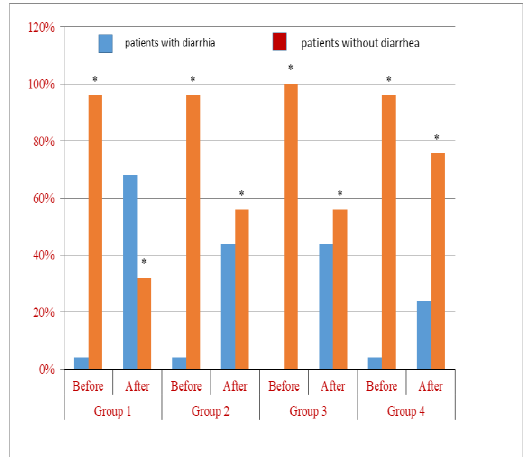
Figure 1. Incidence of diarrhea before and after a specific medication protocol . Group 1 patients taking ciprofloxacin 500mg tablet twice daily for 10 day. Group 2 patients taking ciprofloxacin 500 mg tablet twice daily plus lactobacillus 50 mg capsule twice a day for 10 days Group 3 patients taking levofloxacin 250 mg tablet twice daily for 10 days Group 4 patients taking levofloxacin at dose 250 mg tablet twice daily plus lactobacillus 50 mg capsule twice a day for 10